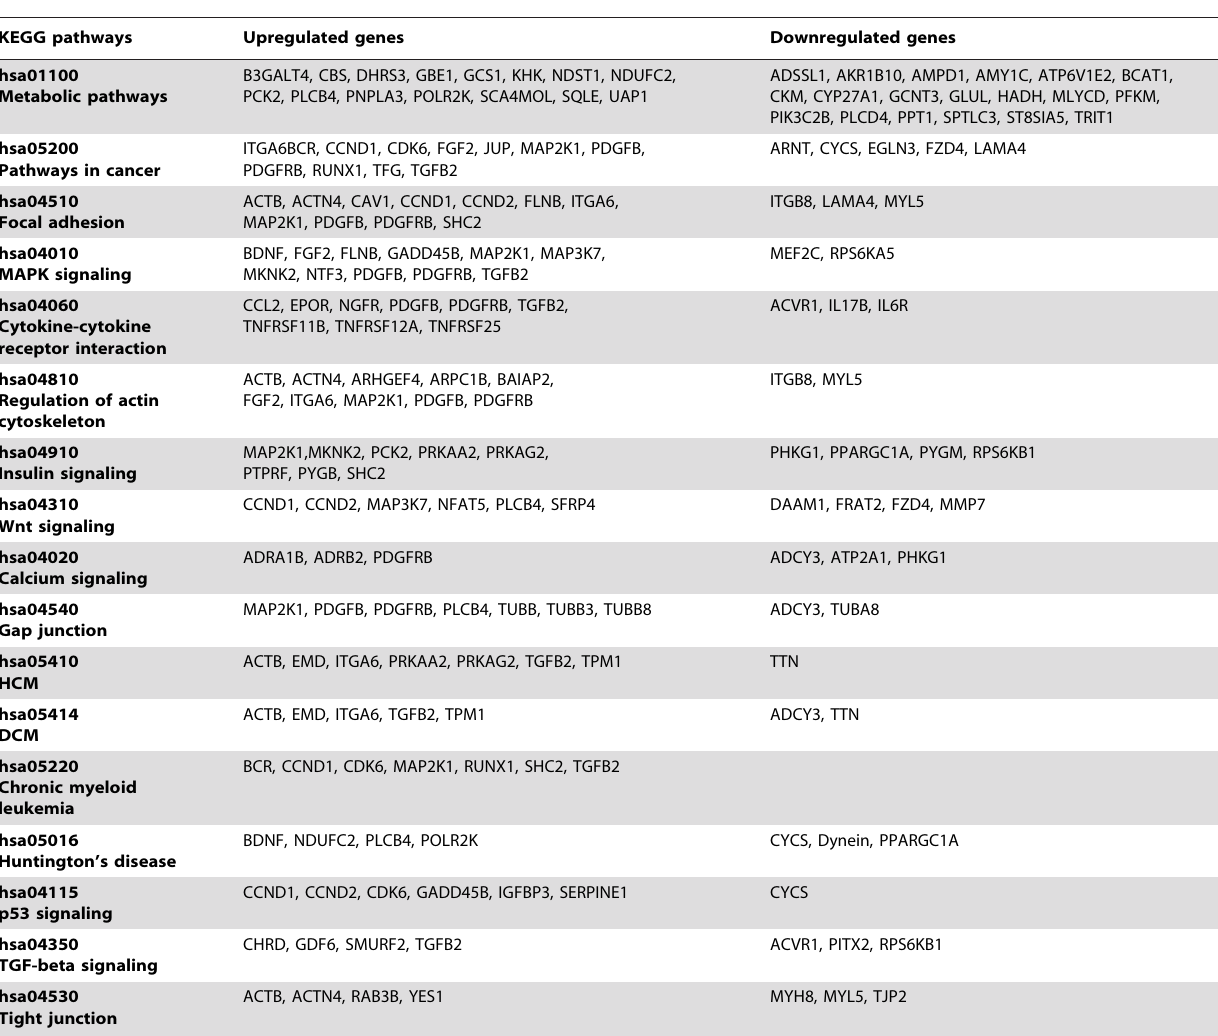
Table 1. KEGG pathways differentially expressed in Ankrd2 silenced myotubes.